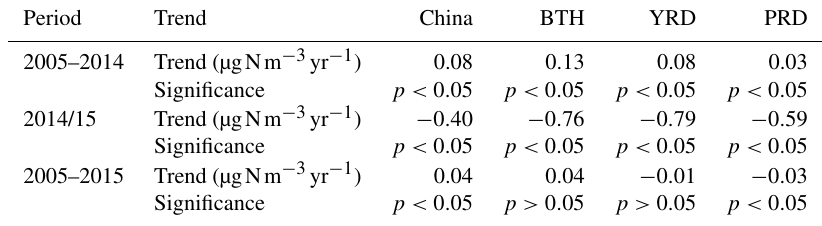
concentrations 3 concentrations. 3